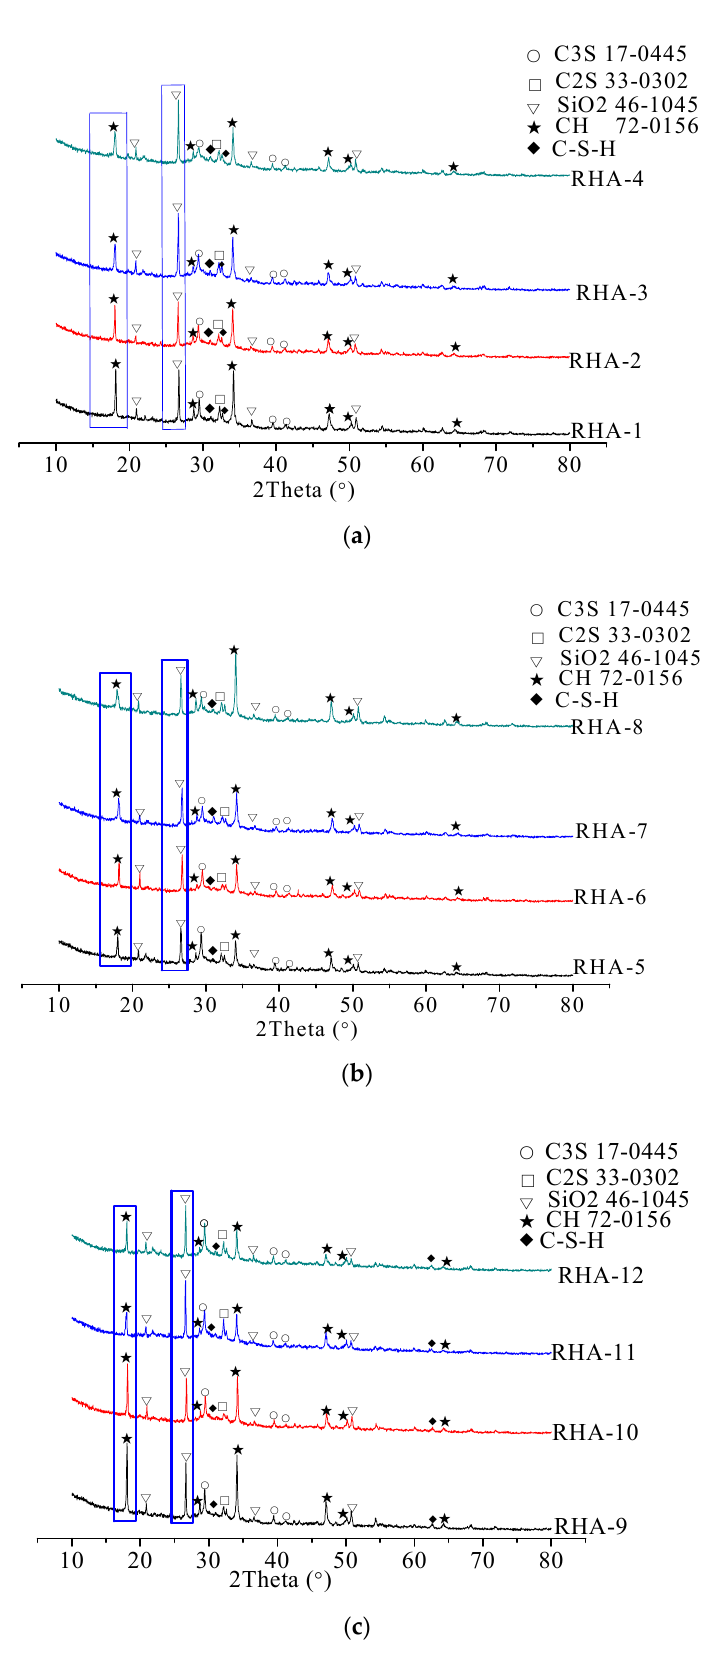
Figure 10. XRD spectra of specimens with RHA: ( a ) w / c ratio of 0.40; ( b ) w / c ratio of 0.45; ( c ) w / c ratio of 0.50.